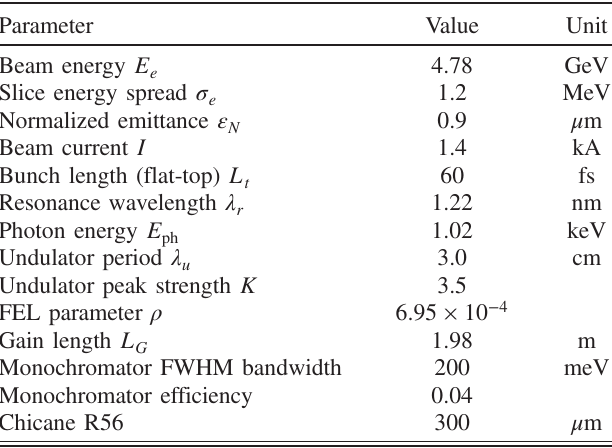
TABLE I. Simulation parameters in 1-D FEL